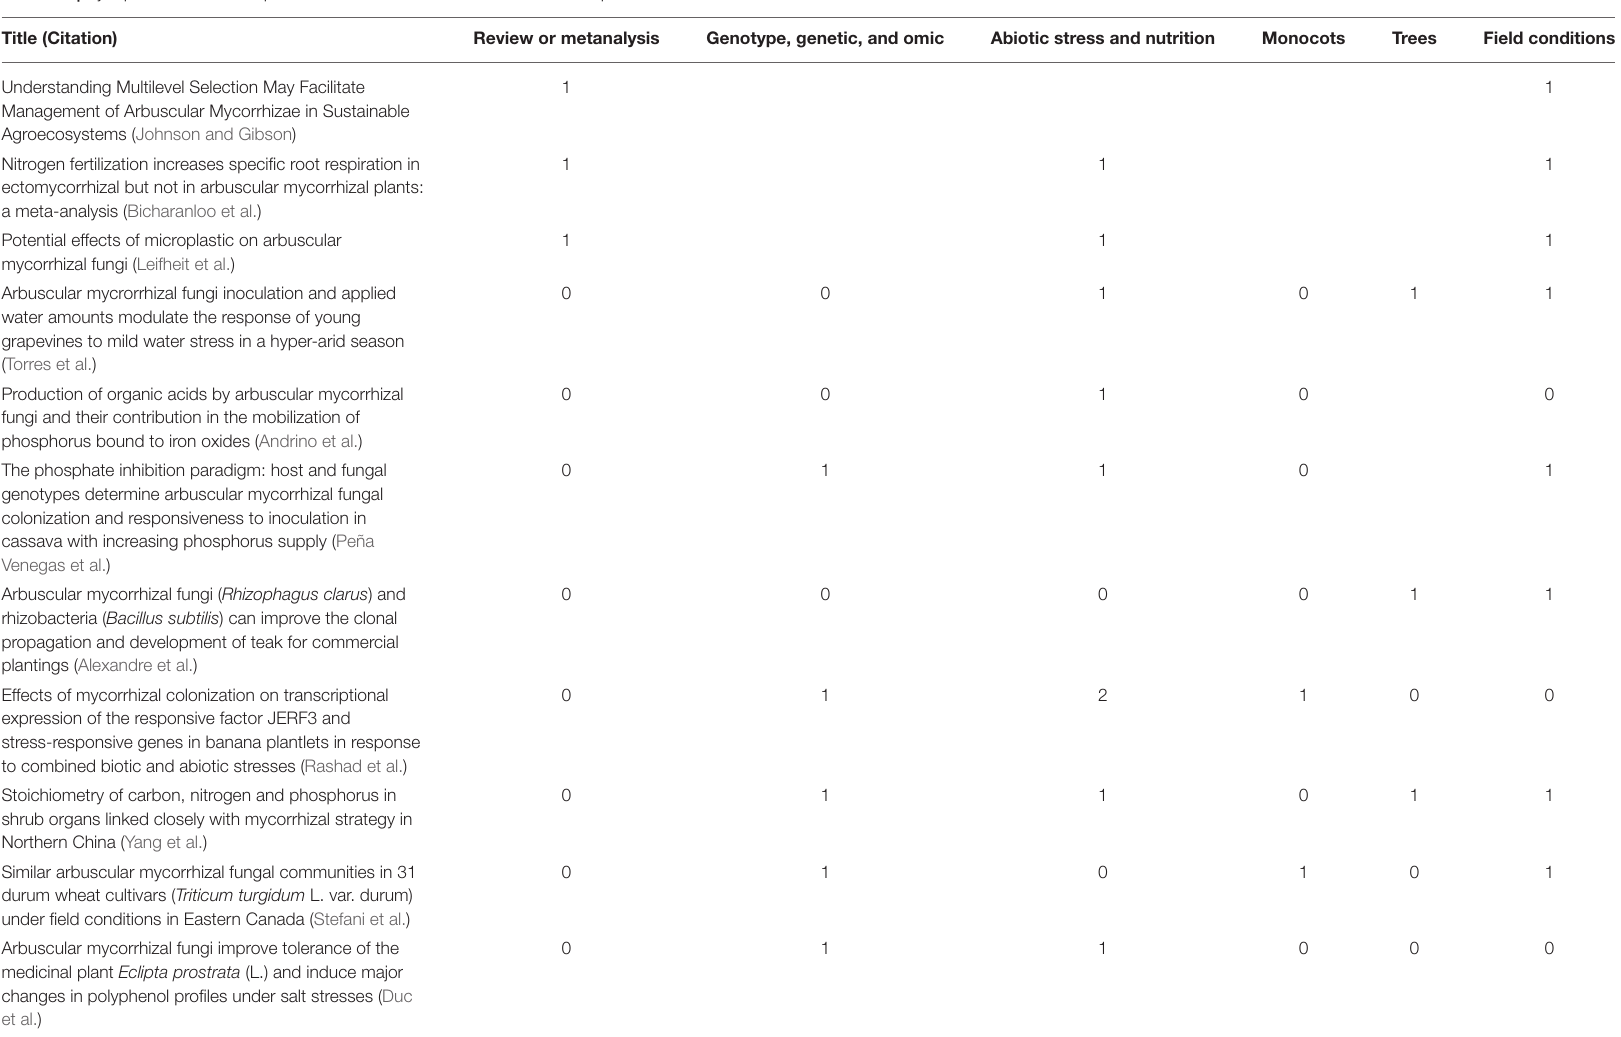
TABLE 1 | Synopsis of the articles published in the collections and number of topics